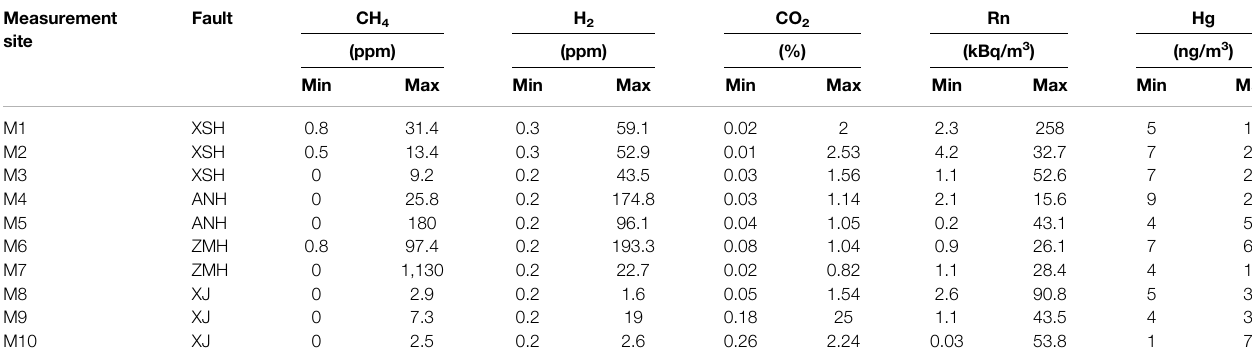
TABLE 1 | Soil-gas concentrations at each measurement site in the XXFS. Measurement site